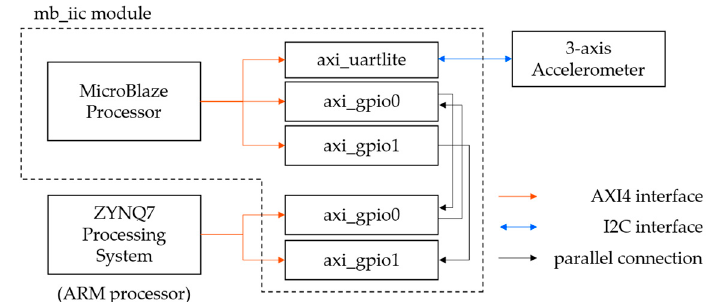
Figure 2. Block diagram of the mb_iic module.